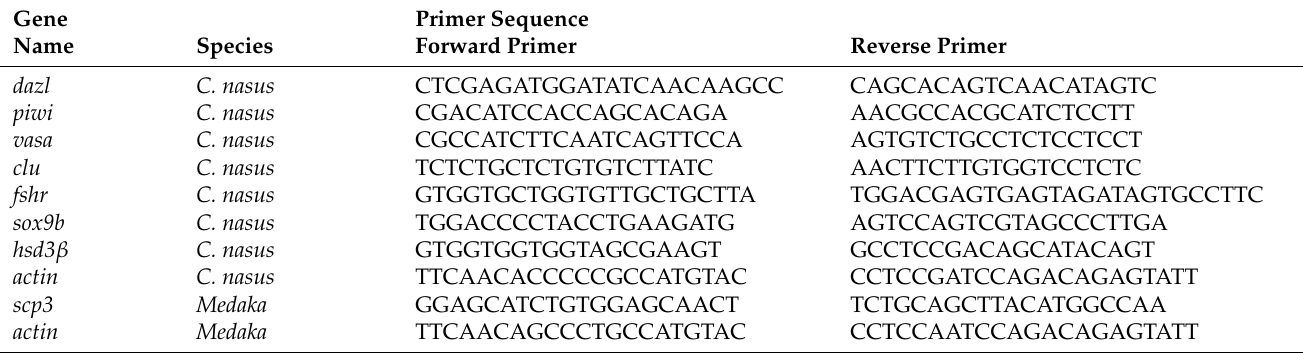
Table 1. Primers used for reverse transcription–polymerase chain reactions